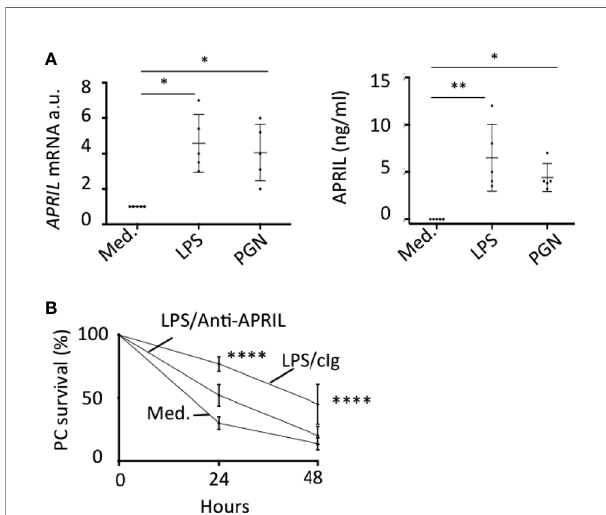
FIGURE 5 | TLR-stimulated APRIL production by epithelial cells sustains plasmocyte survival. (A) HaCat cells were stimulated with LPS and PGN. APRIL mRNA (left panel) and protein in the cell supernatant (right panel) were quanti fi ed by qRT-PCR and ELISA, respectively, after 48 h. Five independent experiments were performed. One-way non-parametric (mRNA) and parametric (protein) ANOVA tests were performed. (B) HaCat cells were seeded in the upper compartment of a transwell and stimulated with 100 ng/ml of LPS for 48 h. FACS-sorted tonsil PCs were added in the bottom compartment. The % of PC survival at the indicated time is shown with 100% de fi ned by the initial PC input. Means +/ − SD are shown. An unpaired parametric two-way ANOVA test was performed. *p < 0.05, **p < 0.01, ****p <